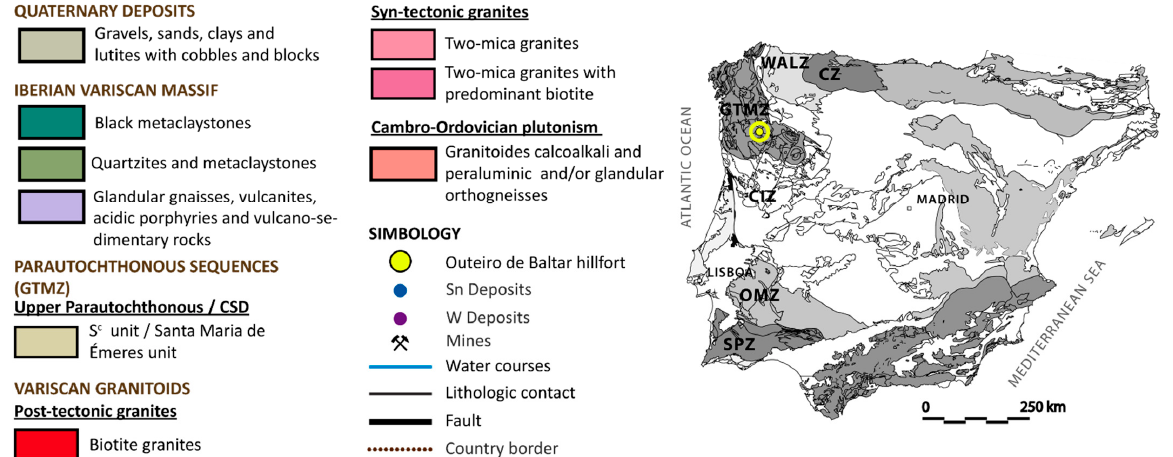
Figure 2. Geological setting of the Outeiro de Baltar hillfort and mining site (redrawn from Ref [23]) (CZ: Cantabrian Zone; WALZ: West Asturian-Leonese Zone; GTMZ: Galicia-Trás-os-Montes Zone; CIZ: Central Iberian Zone; OMZ: Ossa-Morena Zone; and SPZ: South Portuguese Zone). Location of water courses retrieved from Ref [24].